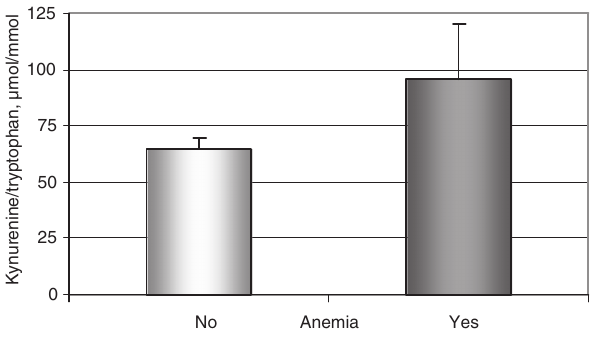
Figure 5 Tryptophan breakdown rate as is expressed by the kynure- nine-to-tryptophan ratio relates to the risk of developing subnormal hemoglobin concentrations and anemia. The data show the results obtained from 39 patients with HIV-1 infection (for comparison, see ref.